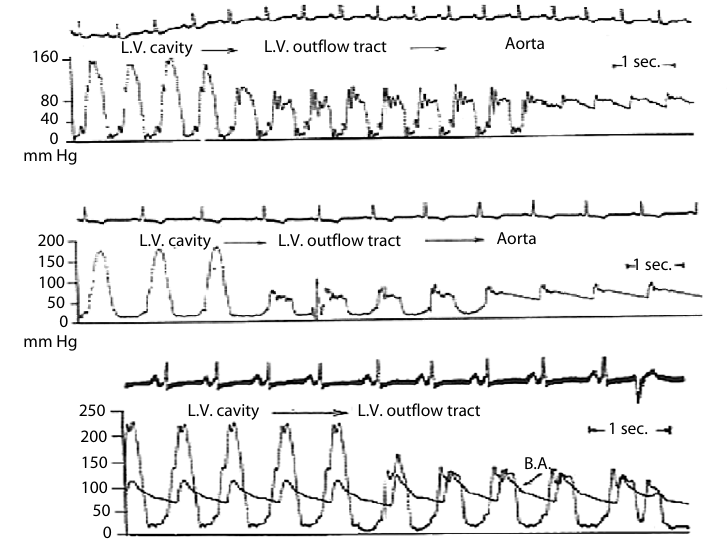
Figure 2. Left heart dynamics in three siblings with obstructive HCM. LV = left ventricular (Ref. [9]).